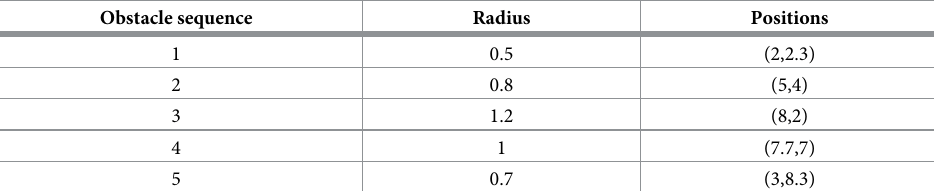
Table 2. The obstacle data in the static environment (5 obstacles). Obstacle sequence